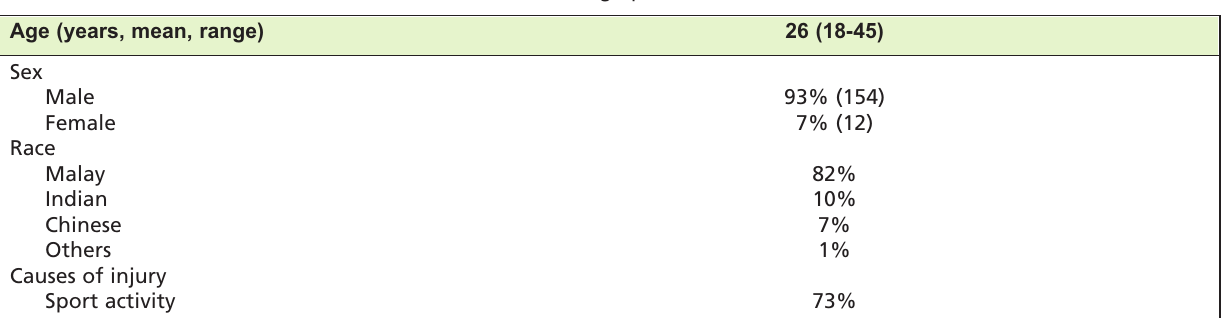
Demographic Table II: